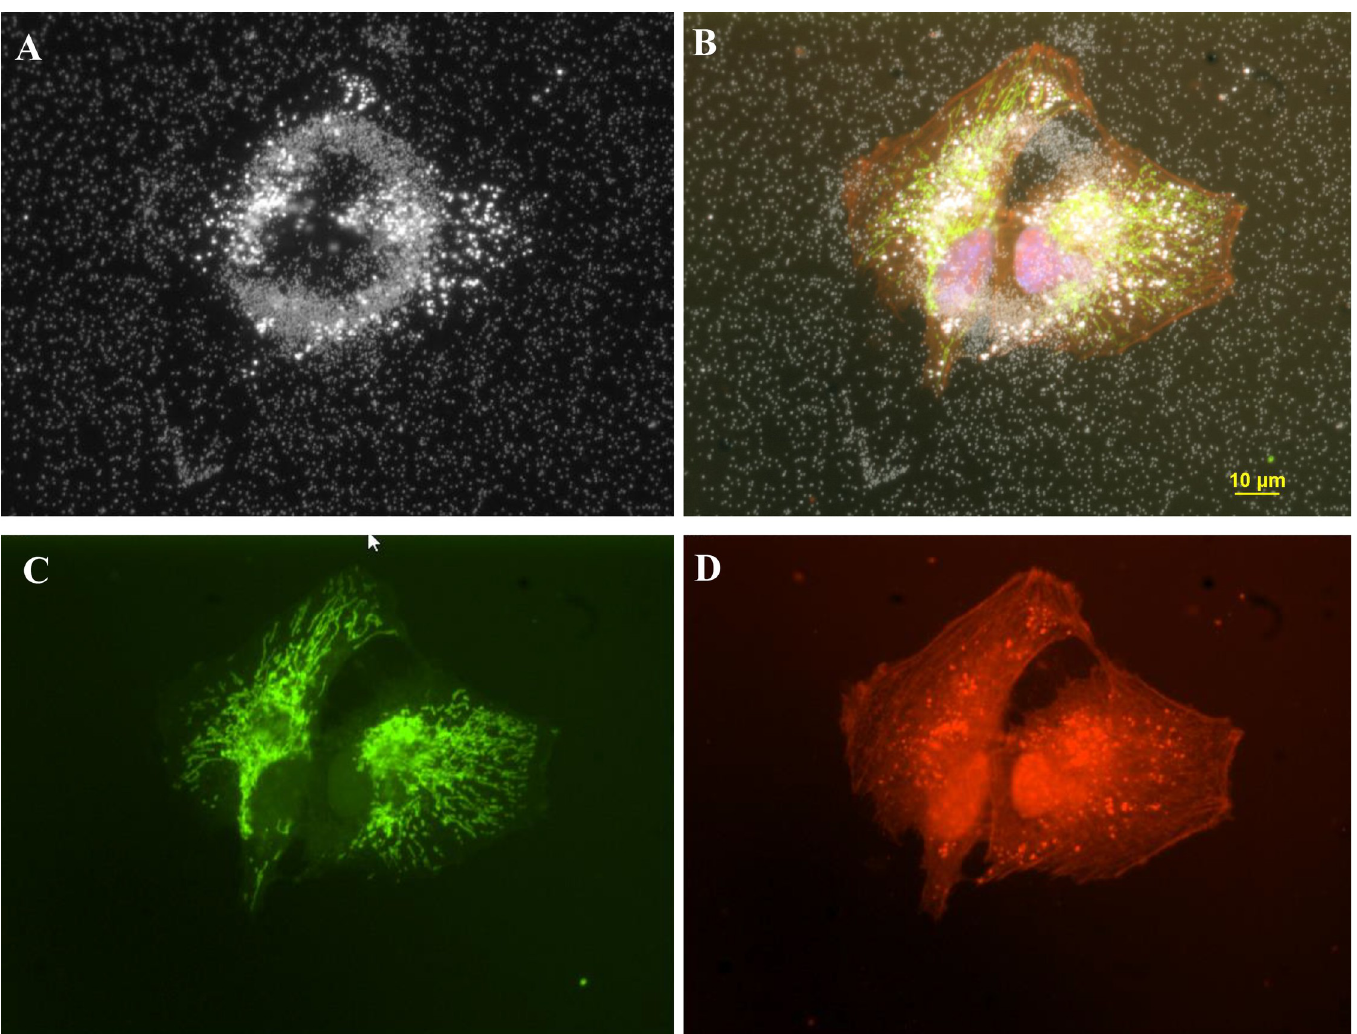
Fig 12. The four-panel figure of cell treated with 3ug/ml AgNP. Panel A. Darkfield image of a ring structure with 2 newly divided daughter cells on top of ring structure. Panel B. The individual dark field (A) and fluorescent images (C, D) were combined into a composite image (B). DAPI stained nuclei (blue) image was added to the composite. Panel C. Cells transfected with Mito-GFP (green). Panel D. Cell stained with CellMask Orange plasma membrane stain. Magnification